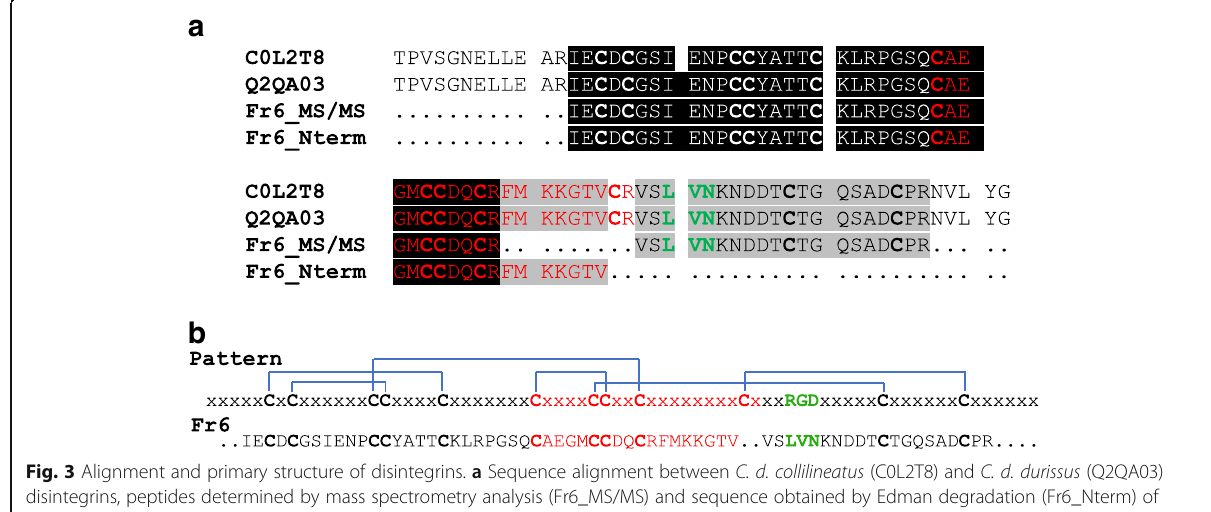
Fig. 3 Alignment and primary structure of disintegrins. a Sequence alignment between C. d. collilineatus (C0L2T8) and C. d. durissus (Q2QA03) disintegrins, peptides determined by mass spectrometry analysis (Fr6_MS/MS) and sequence obtained by Edman degradation (Fr6_Nterm) of Fraction 6. b Comparison between the classical RGD disintegrin structure pattern and the determined primary structure of Fraction 6 (LVN disintegrin). Bold – cysteines ©; Black box – consensus of all data sequence; Gray box – consensus of three data sequence; Red – pattern signature of disintegrin domain involving five conserved cysteines forming disulfide bonds; Green - RGD motif site; Blue – disulfide bond pattern of disintegrin structure; x – any amino acid